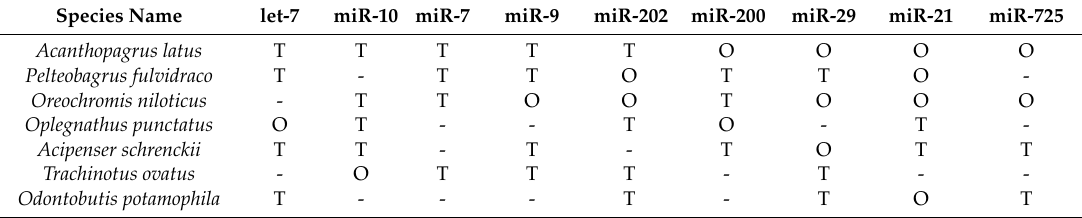
Table 2. Nine important tests- or ovary-biased miRNAs in yellowfin seabream and six reported